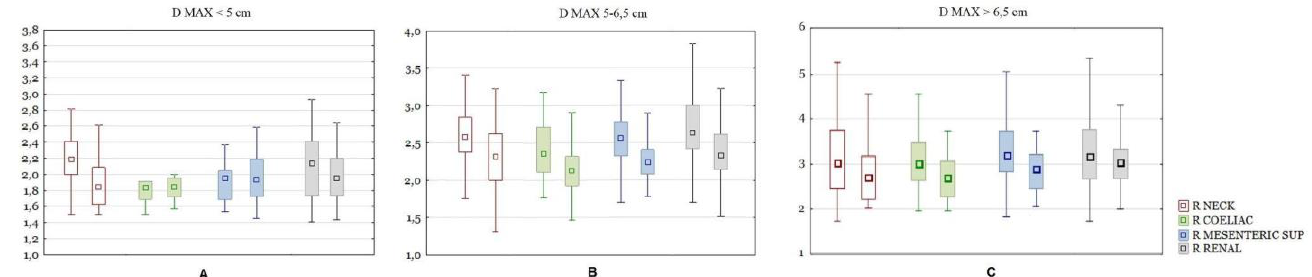
Figure 6. ( A ) A comparison of ratios of the aorta between ruptured and unruptured aneurysms with the neck segment present. Subgroup with D MAX < 5 cm. Boxplots are shown in pairs. The left one is ratio for ruptured, the right one is ratio for unruptured aneurysms. Only the R NECK difference is significant with p < 0.05. ( B ) A comparison of ratios of the aorta between ruptured and unruptured aneurysms with the neck segment present. Subgroup with D MAX 5–6.5 cm. Boxplots are shown in pairs. The left one is ratio for ruptured, the right one is ratio for unruptured aneurysms. All differences significant at p < 0.05. ( C ) A comparison of ratios of the aorta between ruptured and unruptured aneurysms with the neck segment present. Subgroup with D MAX > 6.5 cm. Boxplots are shown in pairs. The left one is ratio for ruptured, the right one is ratio for unruptured aneurysms. Only the R NECK difference is significant with p < 0.05.